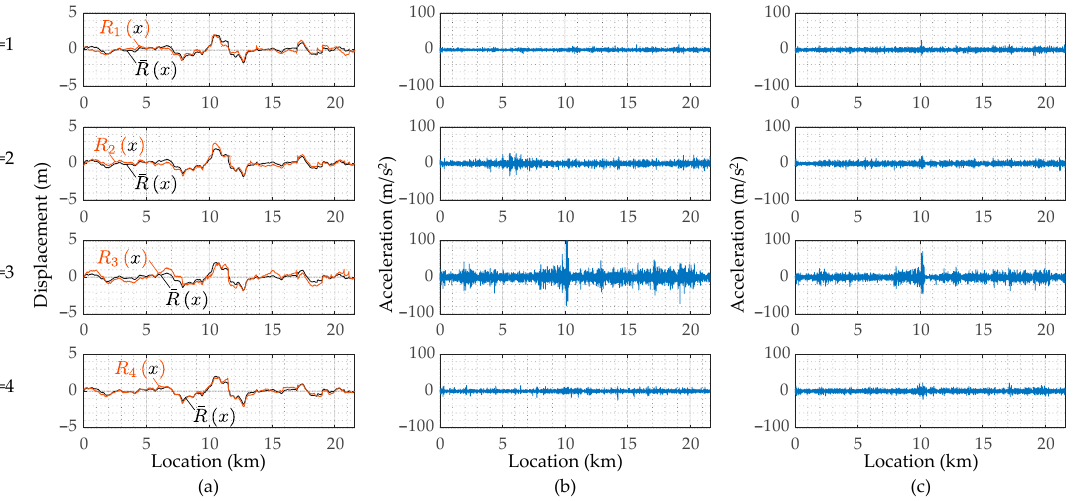
(cid:0) c (cid:1) ) = 20: ( a ) the road profiles, R ( x ) , = 10 and ( k (cid:4673) = 10 and (cid:4672) (cid:3038) (cid:4673) = 20: ( a ) the road profiles, 𝑅 (cid:3036) (cid:4666)𝑥(cid:4667) , esti- i m m .. (cid:3040) (cid:3040) .. r i ( ω ) ; ( c ) the road R i ( x ) , estimated from ˆ .. r ( x ) .